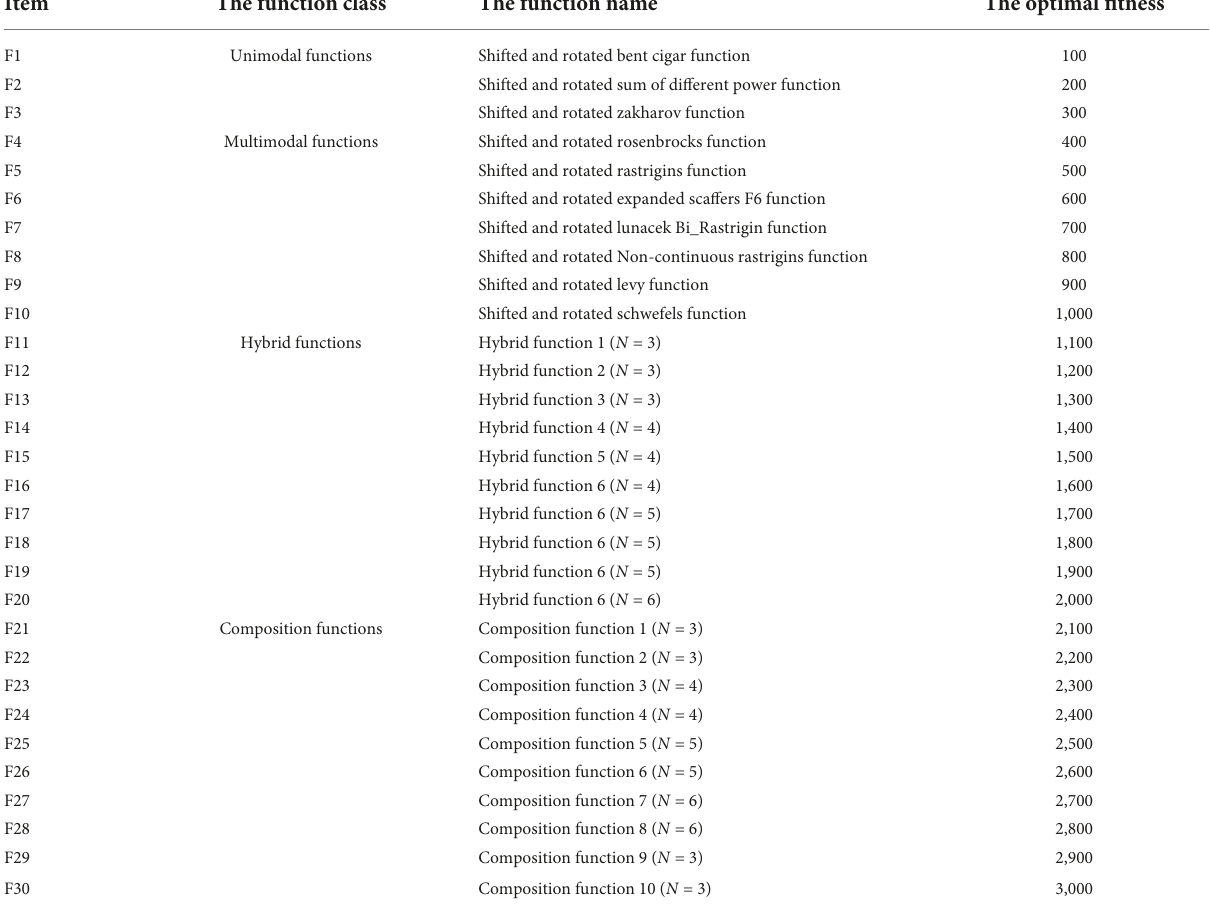
TABLE 5 The detailed 30 benchmark functions of